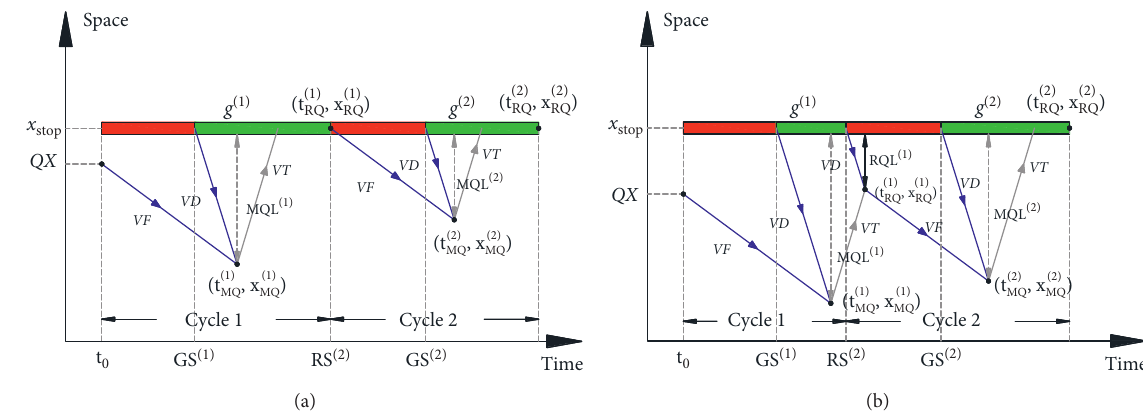
Figure 3: Illustrations for queue intensity. (a) Undersaturated condition. (b) Oversaturated